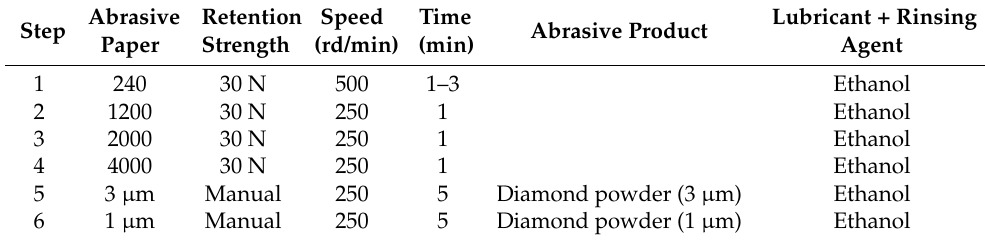
Table A1. Polishing protocol of sections for